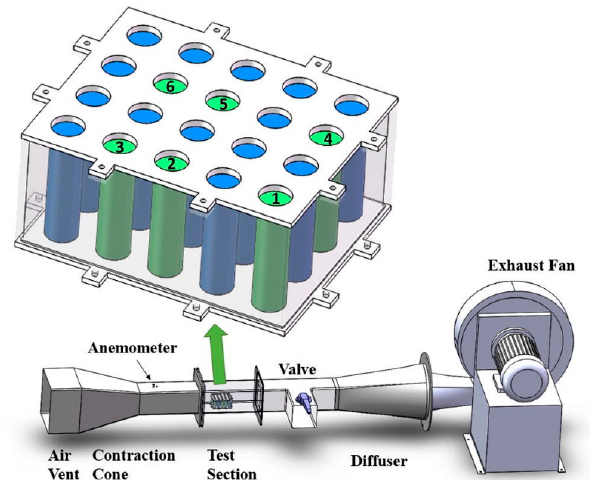
Figure 23. Schematic of a combined battery management system (CBMS) integrated phase change material (PCM) with forced-air cooling. Adopted from Ref. [263]. material (PCM) with forced-air cooling. Adopted from Ref. [263]. Appl. Sci. 2019 , 9 , x